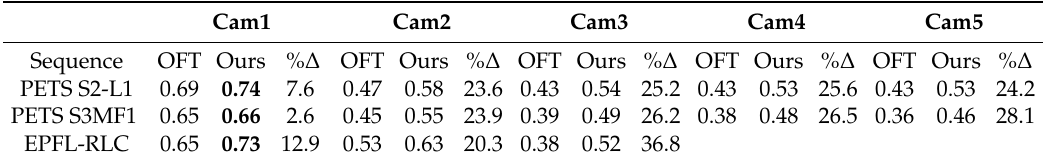
Table 3. F-score (F) results’ values obtained for each camera transferred detection with the faster R-CNN detector [13] and comparison with the use of the Optimal Fixed Threshold (OFT).